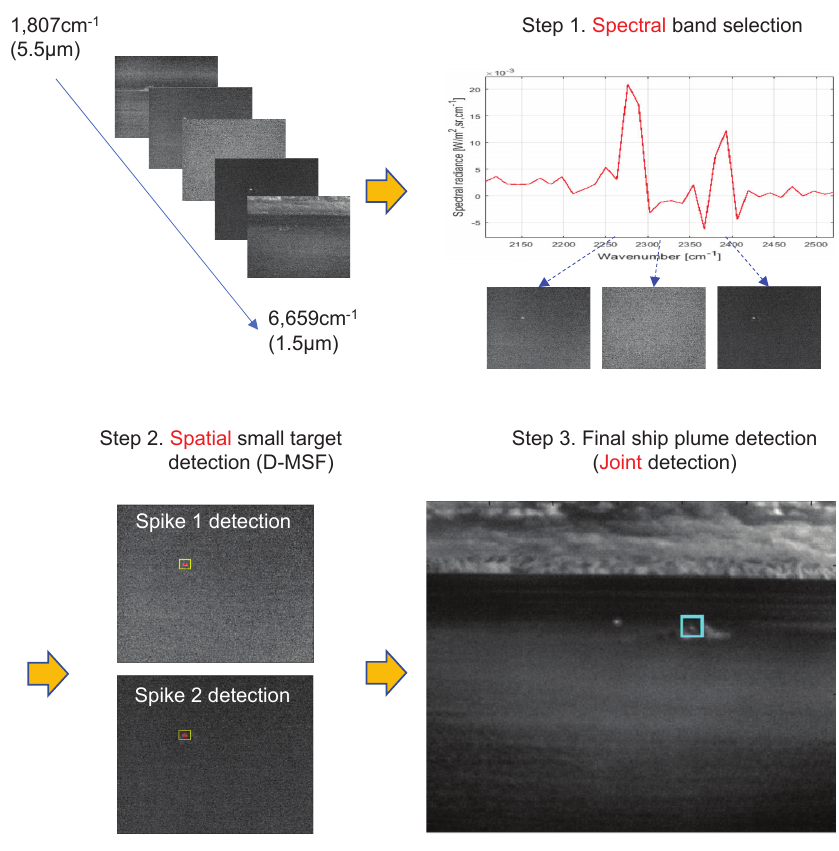
Figure 4. Overall processing flow of remote-ship detection using spectral–spatial information of hot CO 2